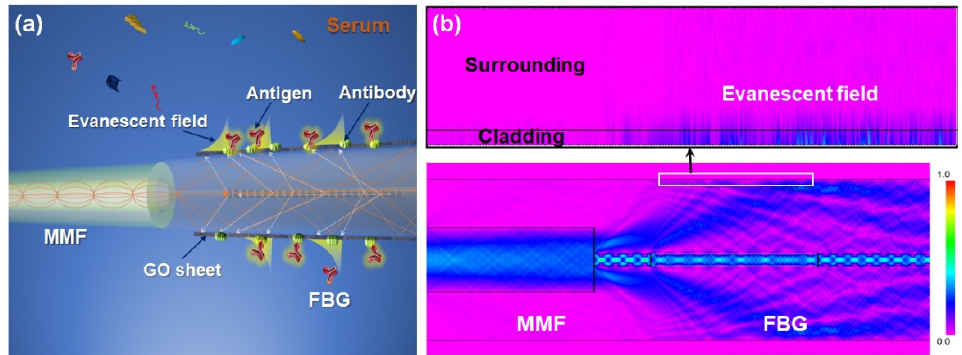
Figure 2. ( a ) The coupling between the optical fiber modes mediated by the RI perturbation caused by protein molecule specific binding. ( b ) The simulated optical field distribution in the FBG.